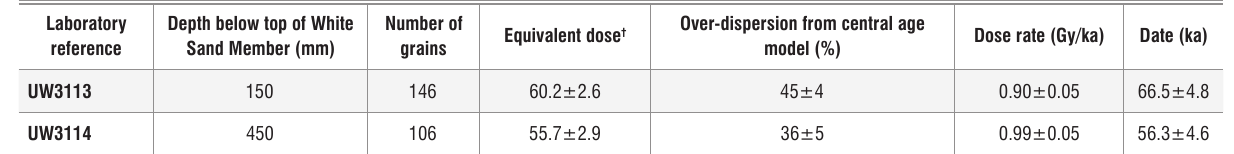
New dates based on optically stimulated luminescence